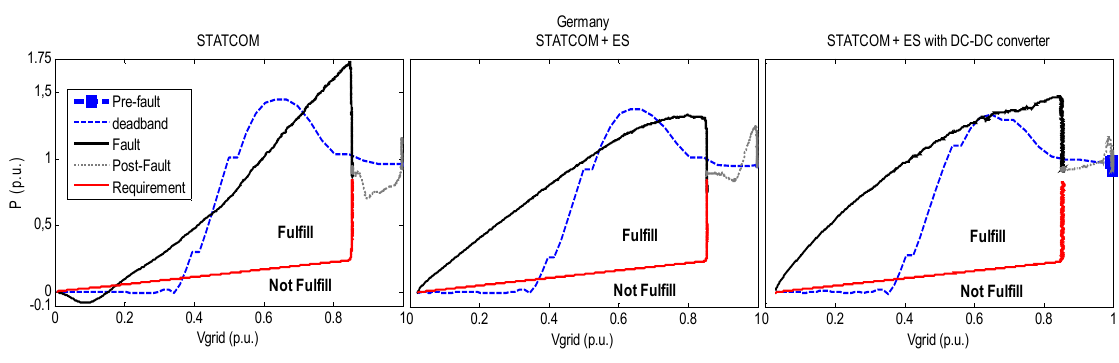
Figure 17. Active power evolution through the voltage dip, German case.